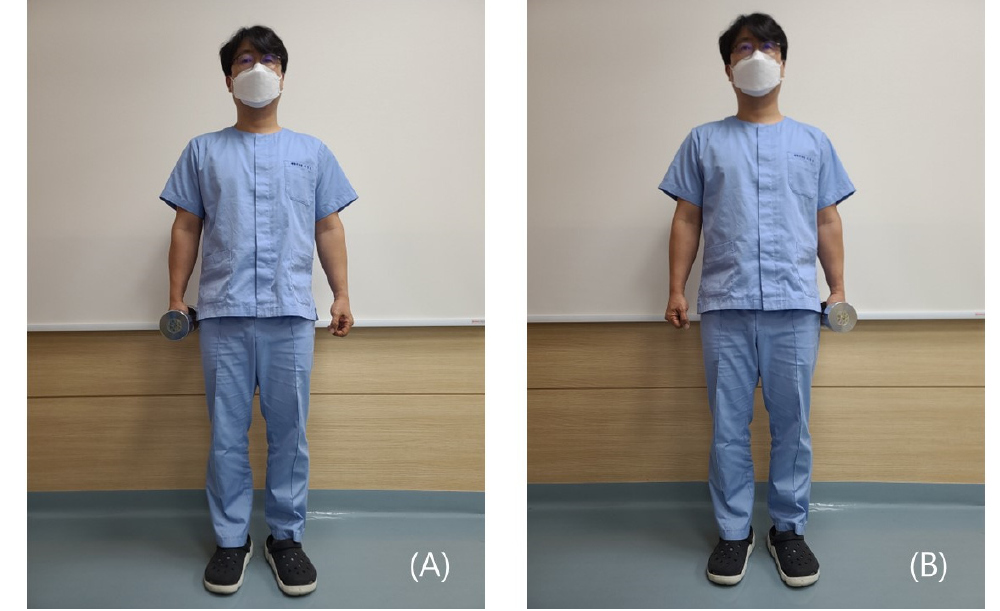
Figure 2. Unilateral weight-bearing tasks. ( A ) Weight-bearing on the right side. ( B ) Weight-bearing on the left side. on the left